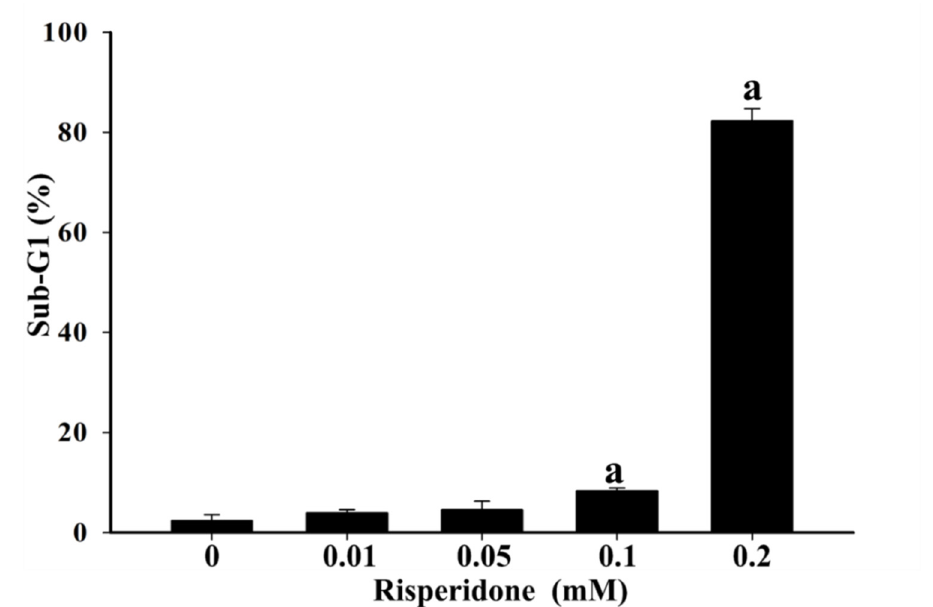
Figure 3. Sub-G1 proportion of SW480 cells in the presence of risperidone. “a” indicates a significant difference ( p < 0.05) compared with the control group. Similar results were obtained in three to six repeated experiments.